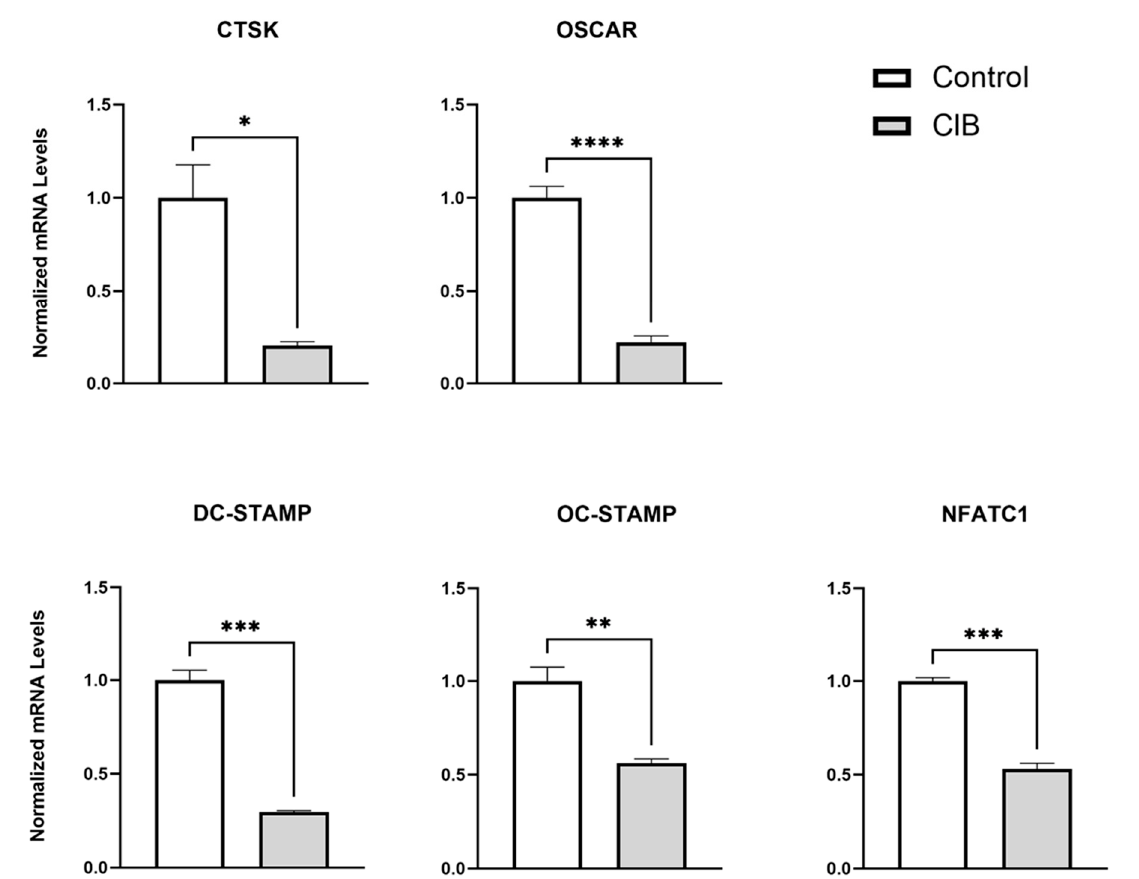
Figure 3. Cibinetide (CIB) downregulates osteoclast-specific genes’ expression. PCR analysis of osteoclast-specific gene expression in BMDMs stimulated with MCSF + RANKL for five days with or without Cibinetide (150 µ M). The expression of Cathepsin K(CTSK), OSCAR, DC-STAMP, OC- STAMP, and NFATC1 were normalized to the housekeeping gene HPRT and then to the mean of the control group. The data are expressed as mean ± SEM of three independent experiments. * p < 0.05, ** p < 0.01, *** p < 0.001, and **** p < 0.0001.